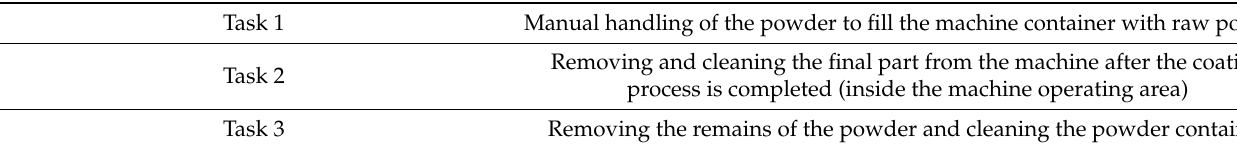
Table 1. Description of the tasks under